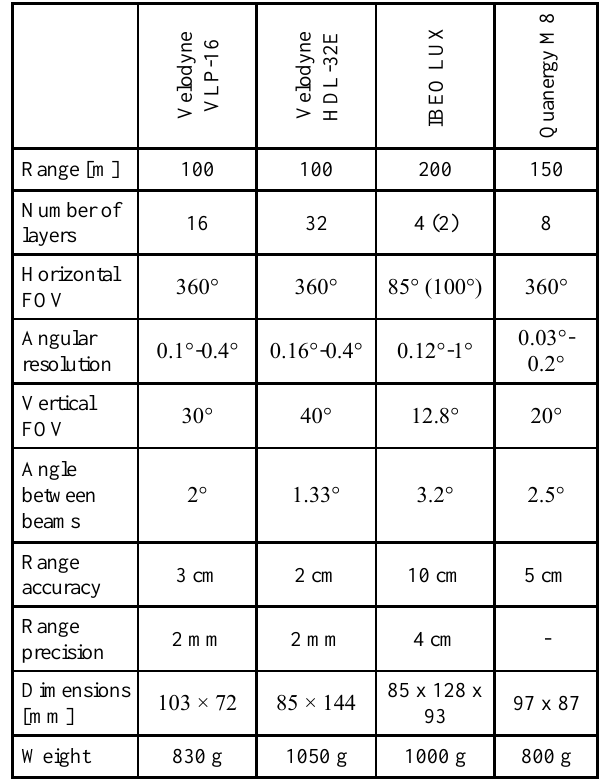
Table 1. Light UAV scanners’